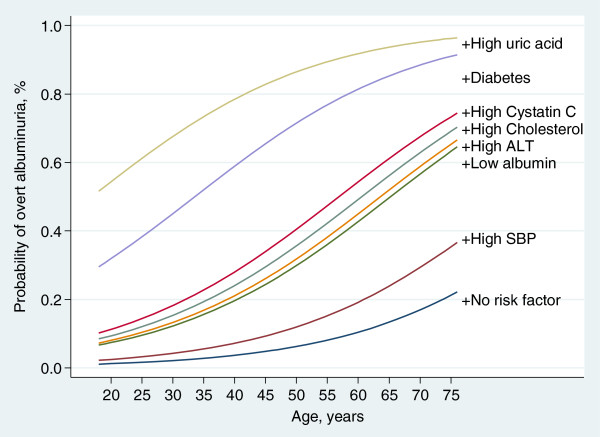
Predicted amplification of overt albuminuria by multiple risk factors.